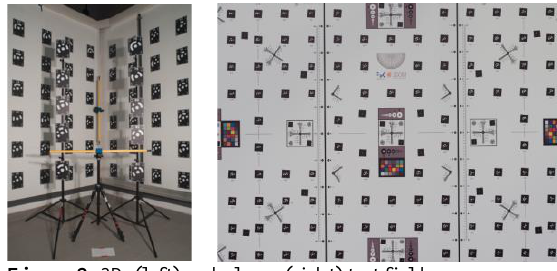
Figure 2 : 3D (left) and planar (right) test